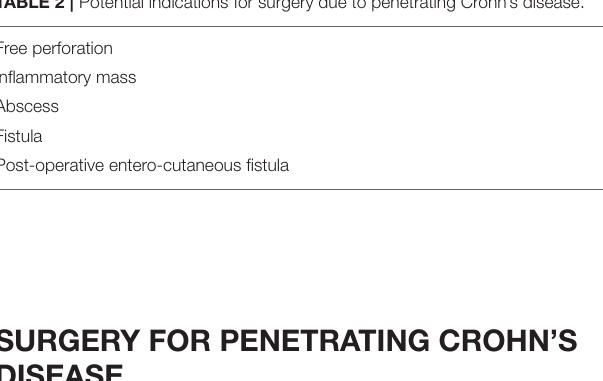
TABLE 2 | Potential indications for surgery due to penetrating Crohn’s